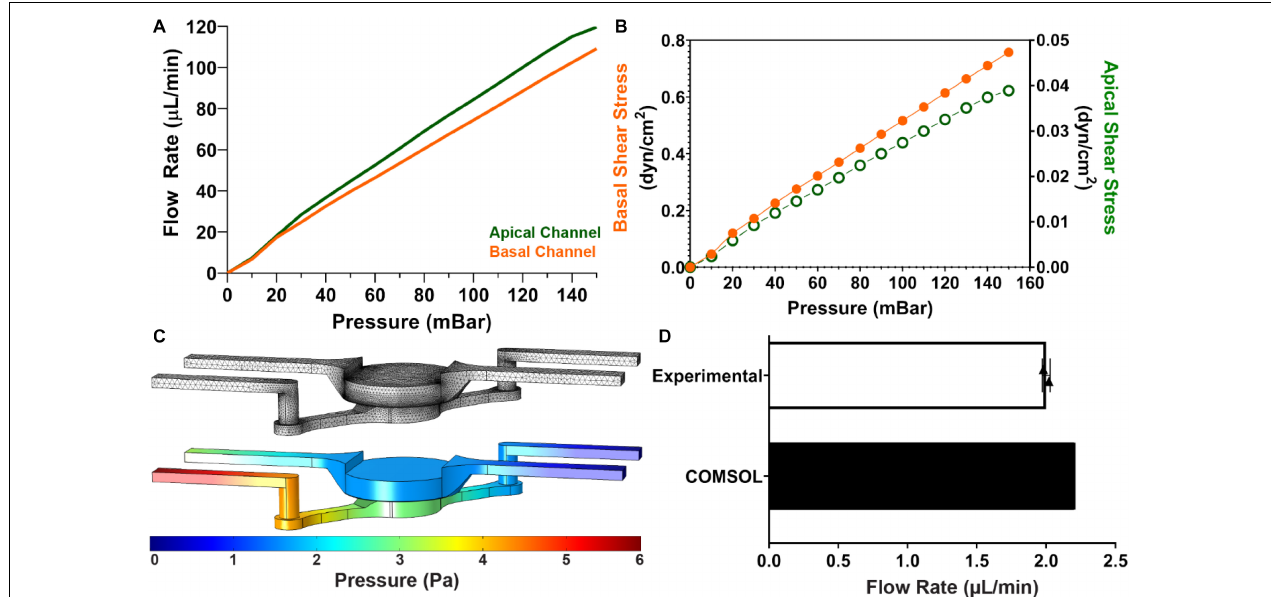
FIGURE 3 | Characterization of Fluid Dynamics in MPS: (A) Cartoon of how glomerular anatomy was modeled within the MPS. Created with BioRender.com. (B) Calculated wall fluid shear stress at the center of the culture well in apical and basal channels. Here, the differences in geometry results in an order of magnitude difference in shear stress. (C) 3D computational fluid dynamics simulation in microfluidic chip. The top image is the mesh implemented for finite element analysis. The bottom image is the 3D volume view of steady state pressure field in MPS at 100 µ L/min inlet flow rate in the apical and basal channels. (D) Fluid flow rate through the membrane separating the apical and basal flow channels determine experimentally and computationally using